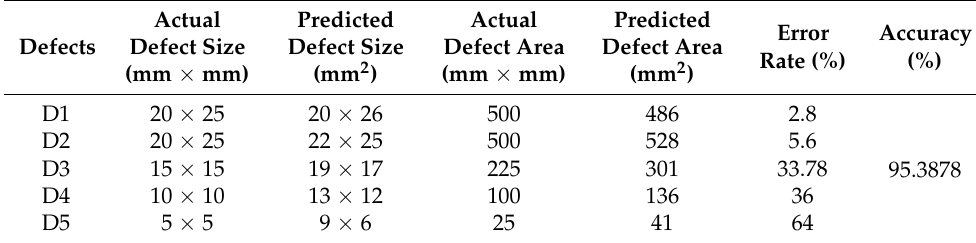
Table 4. Clustering data of the k-medoids clustering